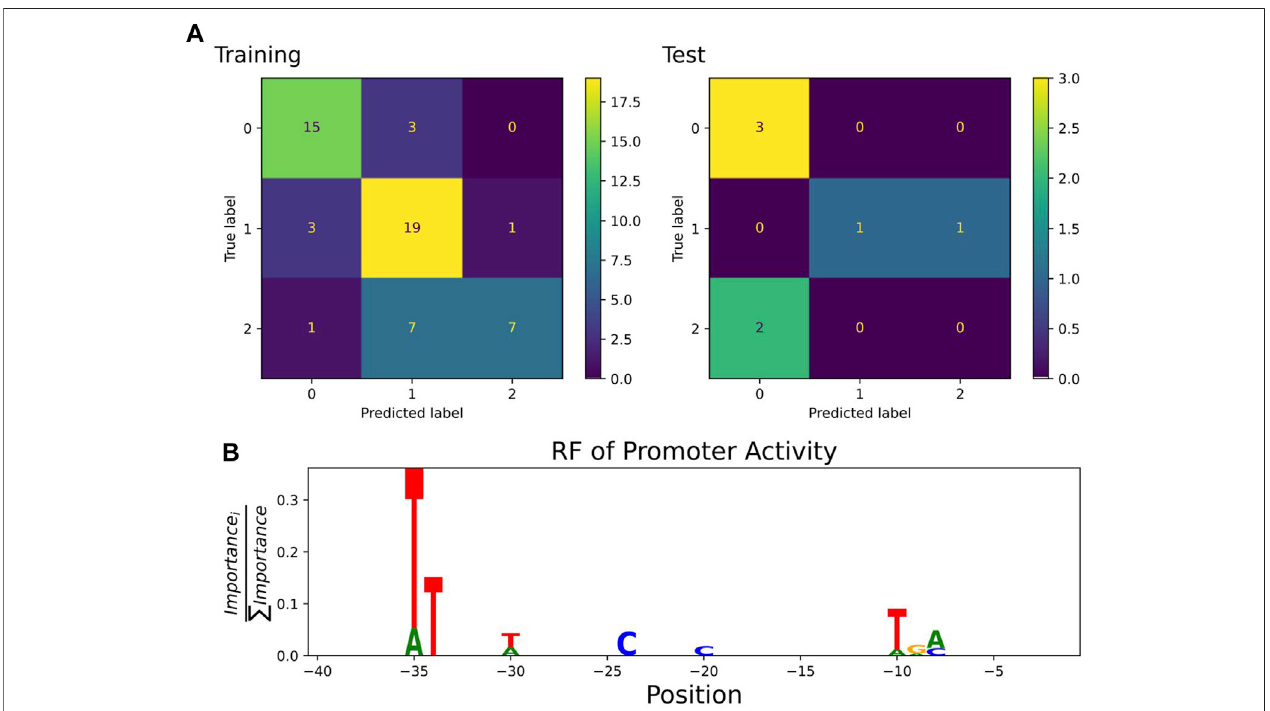
FIGURE 3 | (A) Confusion matrix showing classi fi cation quality for training ( n (cid:1) 56) and test set ( n (cid:1) 7) as predicted by the best random forest estimator. The classi fi cation labels are 0: low (expression 0.2 – 16.6), 1: medium (16.6 – 24.8), 2: high (24.8 – 35.2) (Köbbing et al., 2020). (B) Sequence logo of positions used by the estimator to predict expression activity class. The − 35 and − 10 box positions dominated the feature importance.